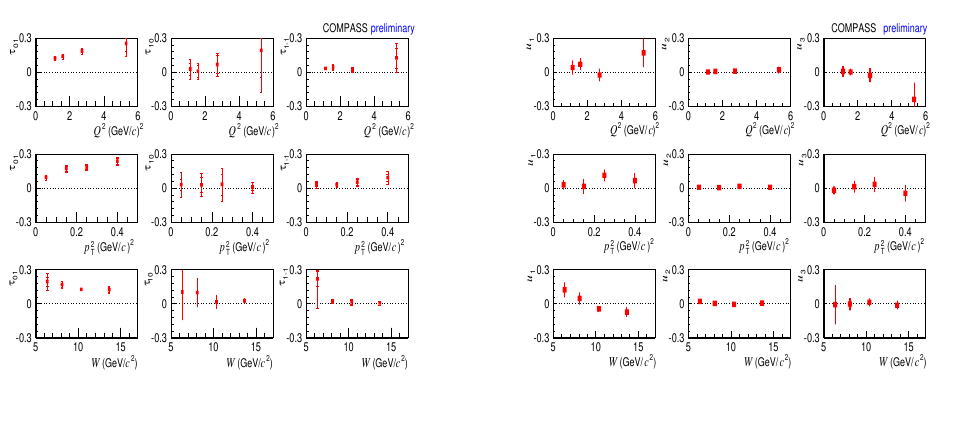
Figure 5: The dependences of τ in the left panel (right